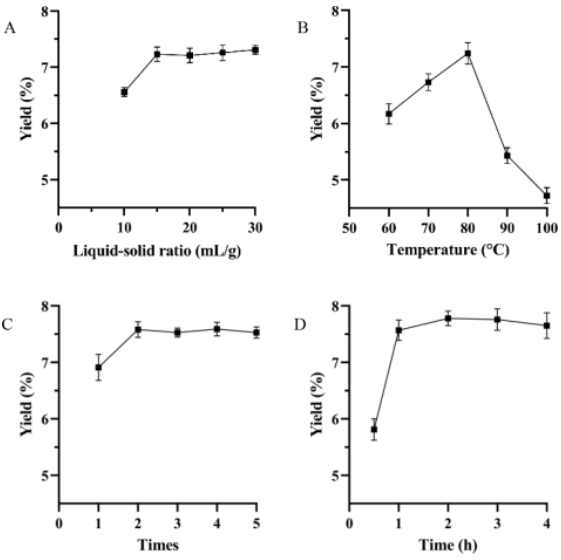
Figure 1. The effect of extraction factors on the yield of polysaccharides ( n = 3): ( A ) liquid/solid ratio; ( B ) temperature; ( C ) times; ( D ) time.